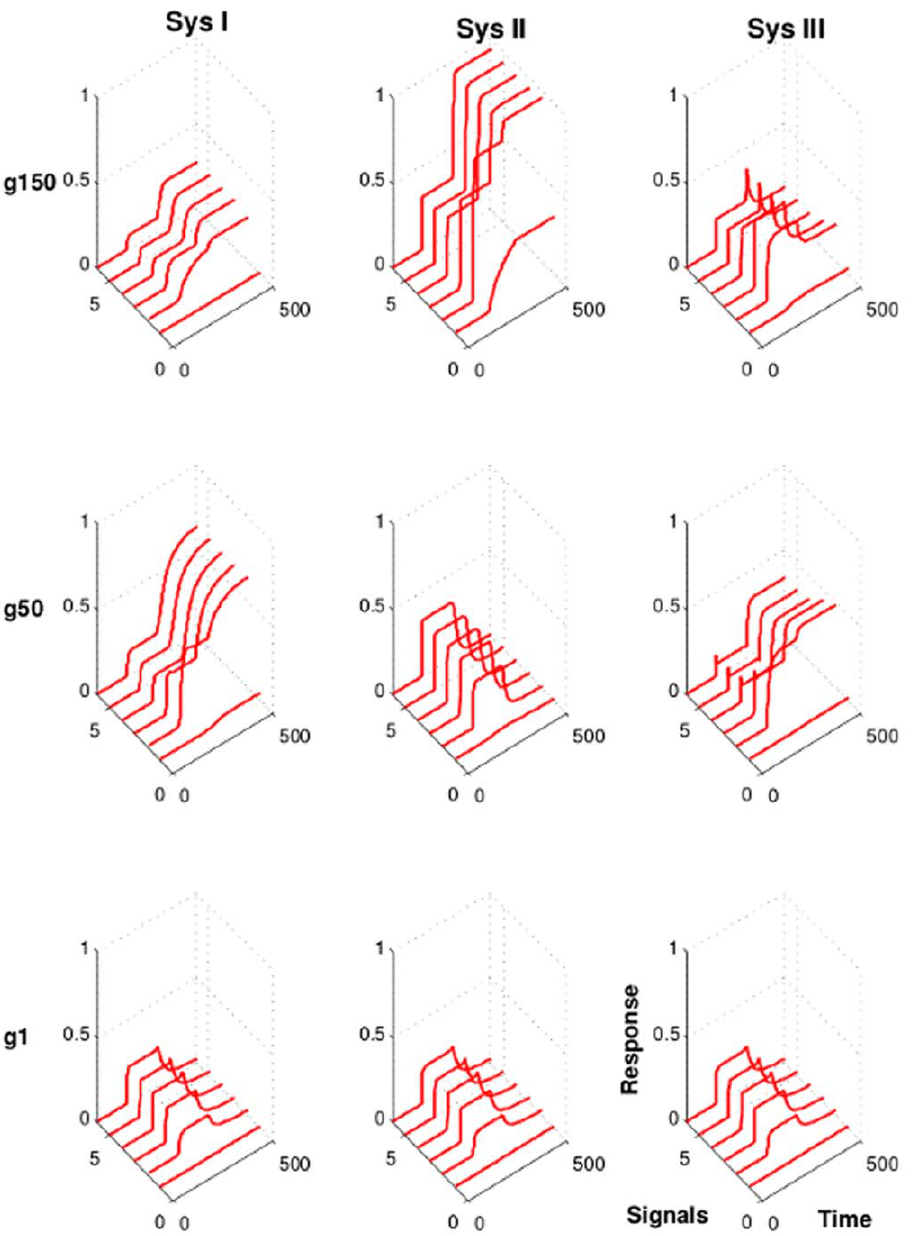
Figure 7. Effect of the removal of the input signal on the kinetics of evolved networks. Shown are the networks with the highest fitness score from one representative simulation run. g 1 , g 50 , and g 150 denote the generation 1 , 50 , and 150 , respectively. The six solid lines show the kinetics of activation of the output node in response to six different input signal strengths (strength increases with signal index). Sys I, weak interactions ( k v 10 ). Sys II, moderate interactions ( k v 30 ). Sys III, strong interactions ( k w 30